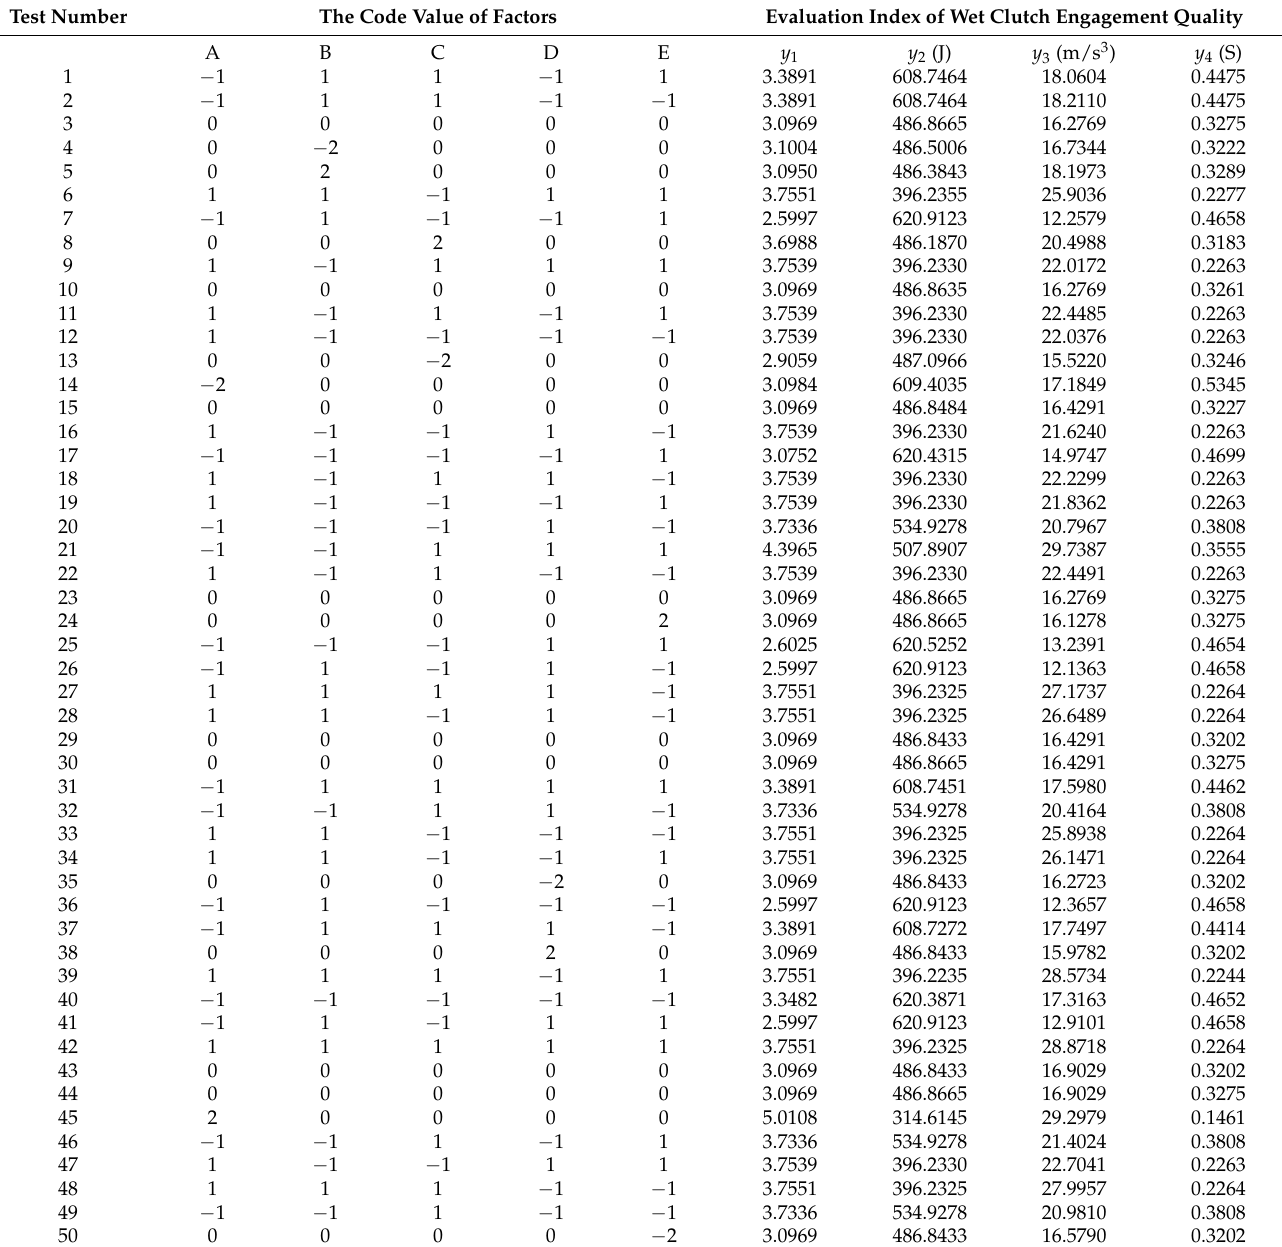
Table 4. RSM test design and results of different oil filling curves on the wet clutch engagement